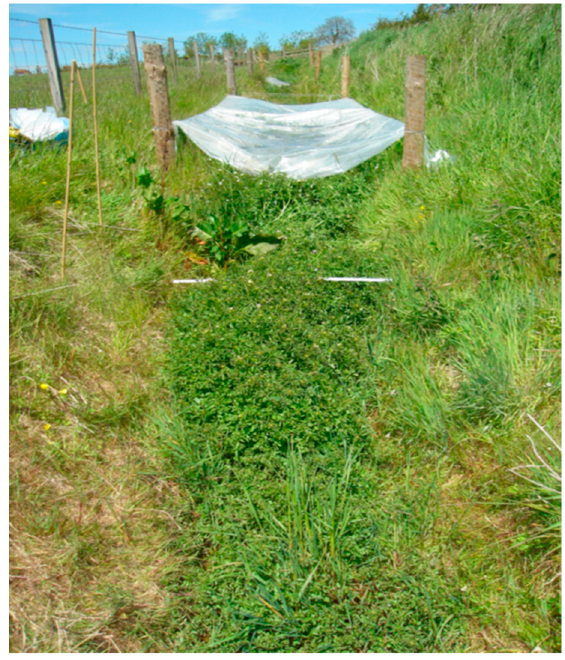
Figure 2. Seeded ditch in May 2014, showing uncovered and plastic-covered segments of the ditch.